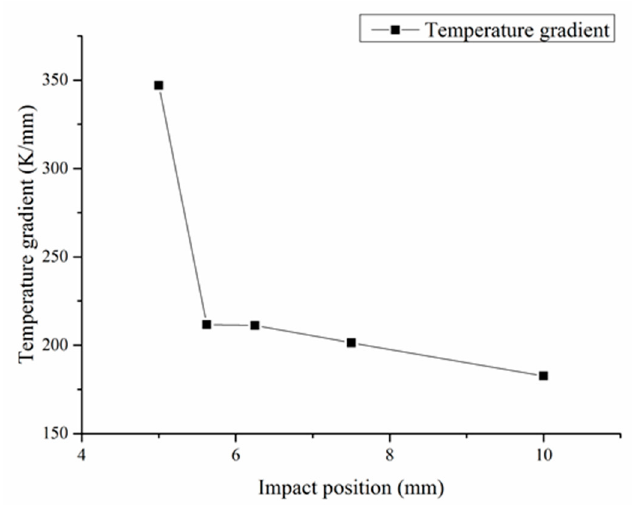
Figure 6. The temperature changes at different injection point positions.